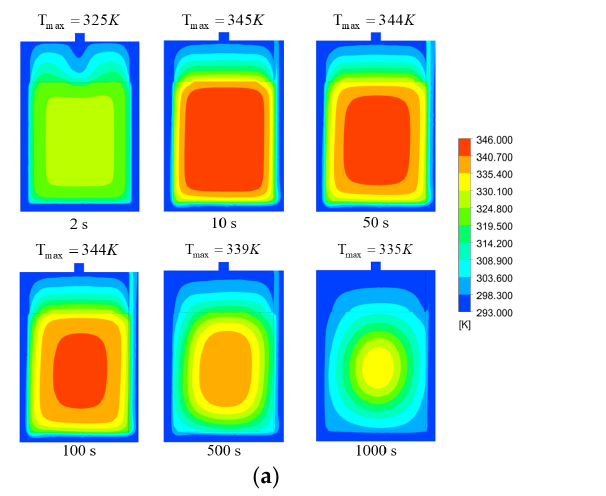
Figure 7. Time-varying curves of average temperature and hydrogen storage percentage by weight in the reaction zone subjected to different cooling water flow rates. ( a ) Average temperature; ( b ) Percentage by weight.